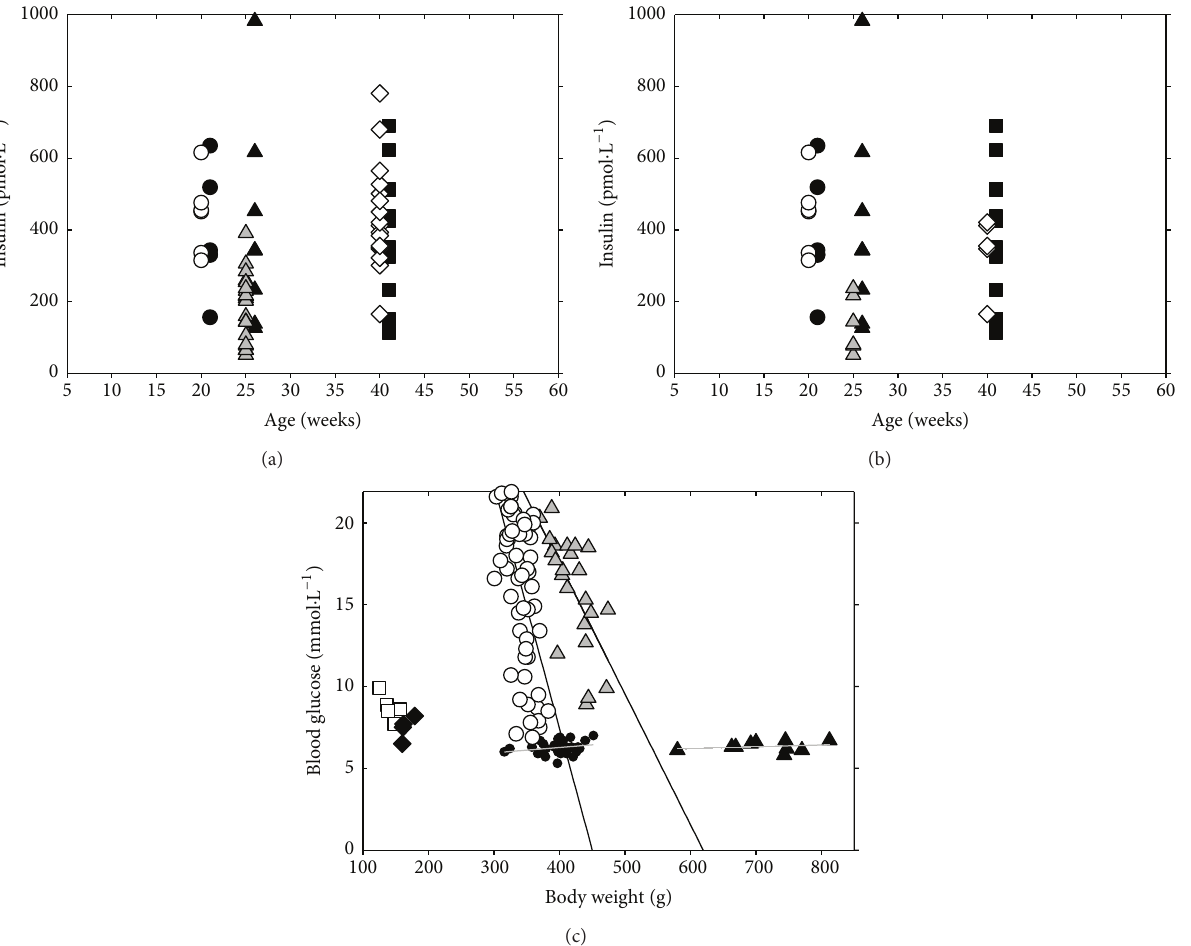
Figure 8: Postprandial circulating insulin levels and relationships between fasting blood glucose and body weight during maturation and aging of Wistar and Goto-Kakizaki rats. Wistar rats : black symbols ; GK rats : gray and white symbols . Postprandial insulinemia in blood of (a) all studied GK rats versus Wistar rats; (b) hyperglycemic GK rats were selected versus all studied Wistar rats at age as indicated; and (c) relationship of blood glucose in a fasting state on body weight at the age of six weeks (white squares; black diamonds), 15 weeks (circles), and 37 weeks